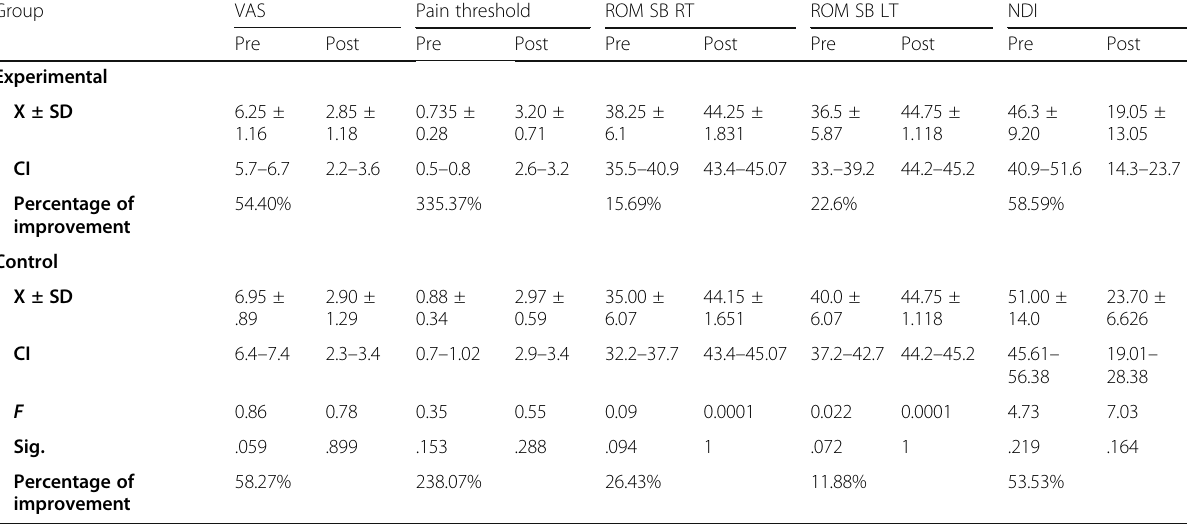
Table 2 Comparison between the dependent variables between study groups Group VAS Pain threshold ROM SB RT Experimental